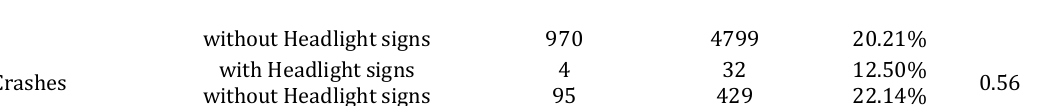
Table 7: Ratio of Odds Ratio Analysis for Headlight Sign Controlling for the DRL Technology